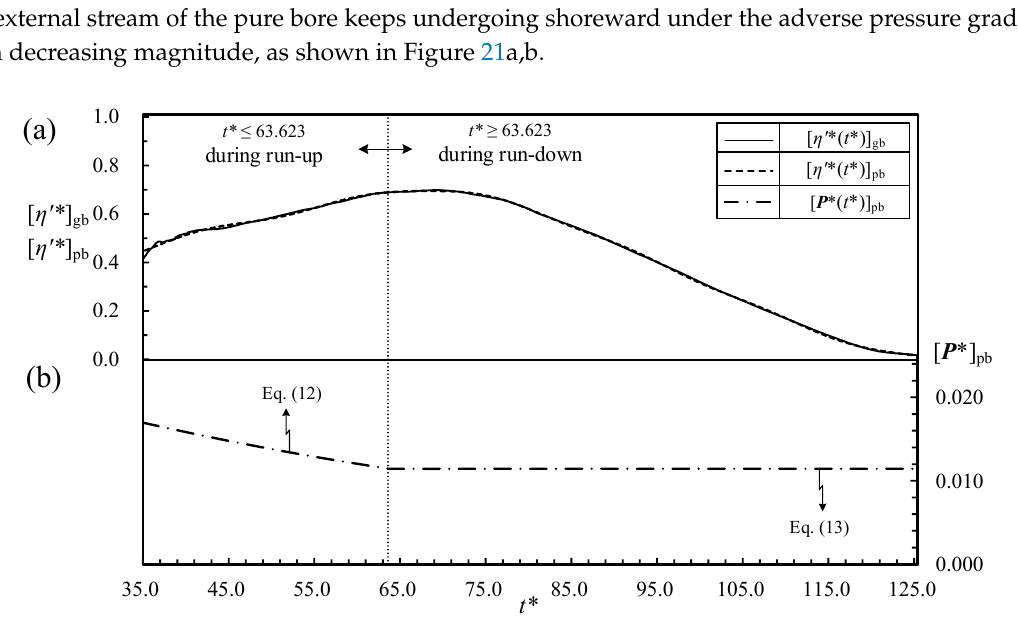
Figure 21. Variations of ( a ) [ η ′ *( t *)] gb and [ η ′ *( t *)] pb ; ( b ) [ P *( t *)] pb with t * during run-up and run-down for 35.0 ≤ t * ≤ 63.623 and 63.623 ≤ t * < 125.284, respectively.